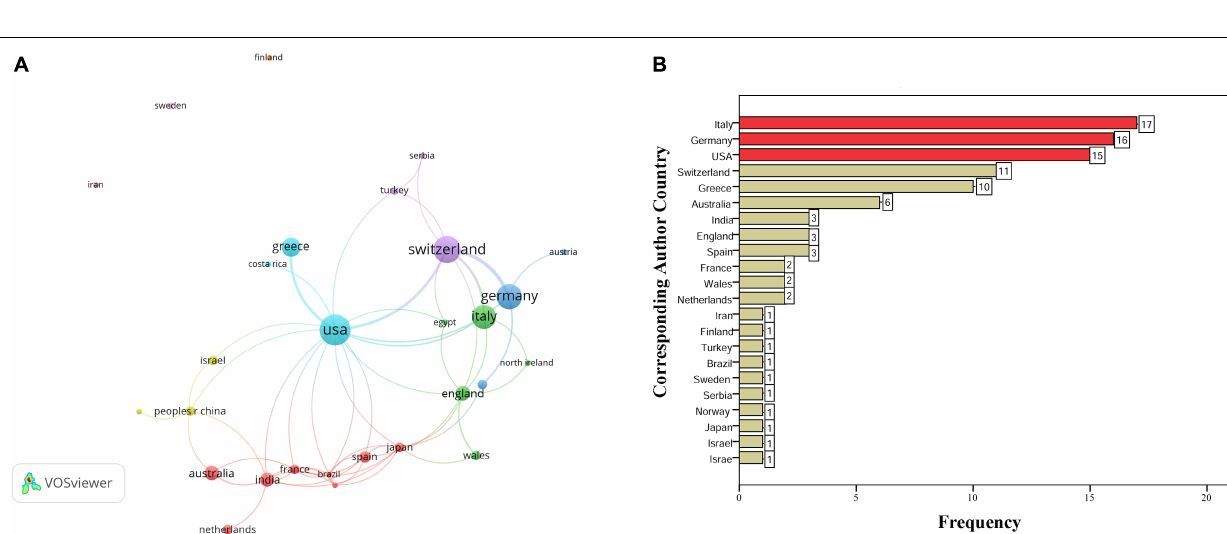
Frontiers in Medicine |